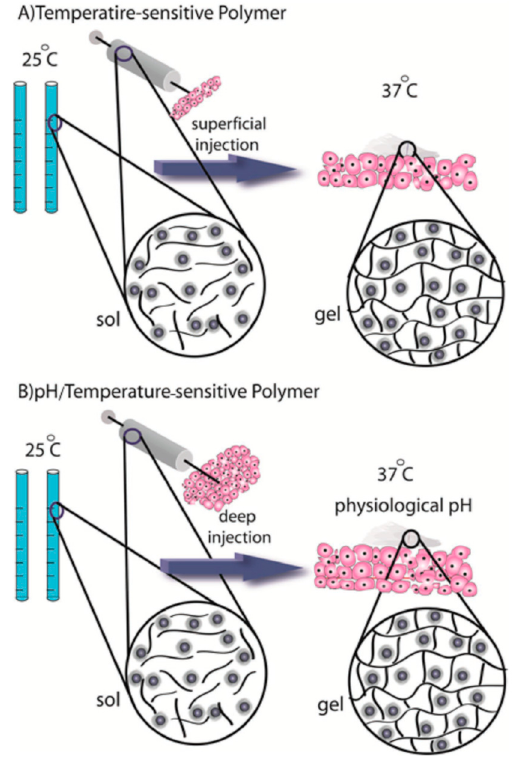
Figure 6. Illustration of stimuli-responsive mechanisms employing ( a ) temperature-sensitive polymer reactivity and ( b ) pH/temperature-responsive polymer reactivity undergoing sol–gel transition (adapted with permission from Reference [4]).